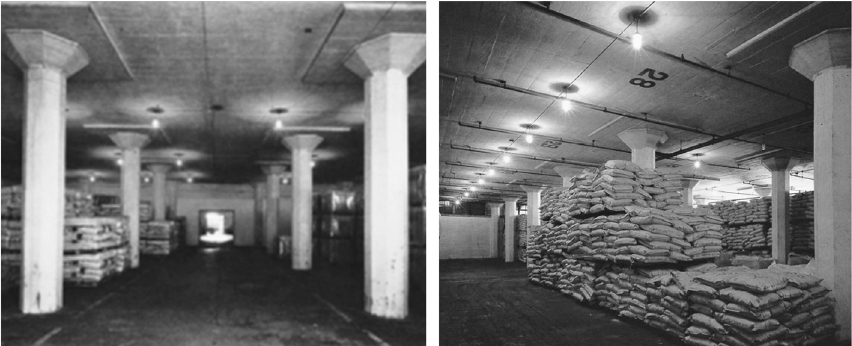
Fig. 5 Historical photos of Yong ’ an Warehouse (Source: Research on Spatial Characteristics of Industrial Heritages and Protection Strategies at Yangpu Waterfront, Professor Qing Chang ’ s team, August 2016)